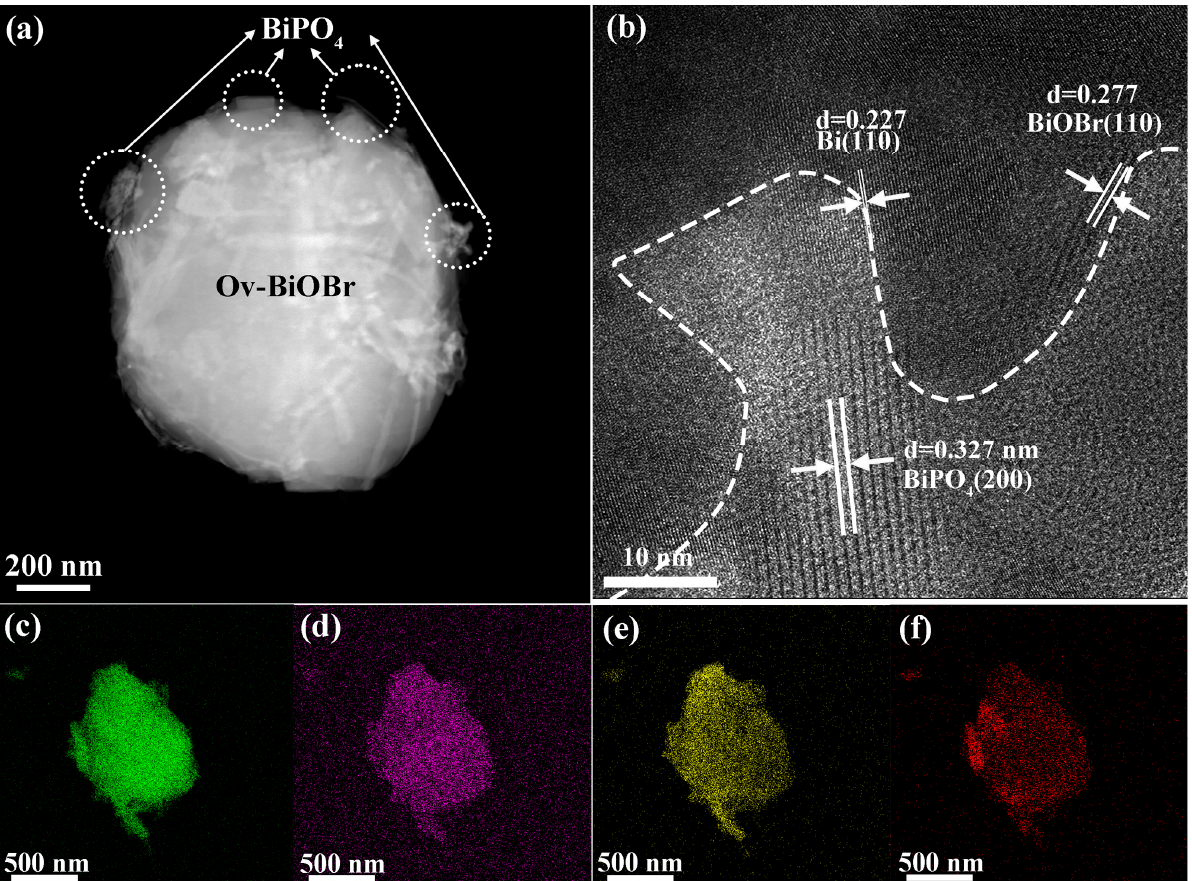
Figure 2. TEM image ( a ), HRTEM image ( b ), and elemental mapping of Bi ( c ), Br ( d ), O ( e ), and P ( f ) of BiPO 4 /Ov-BiOBr.